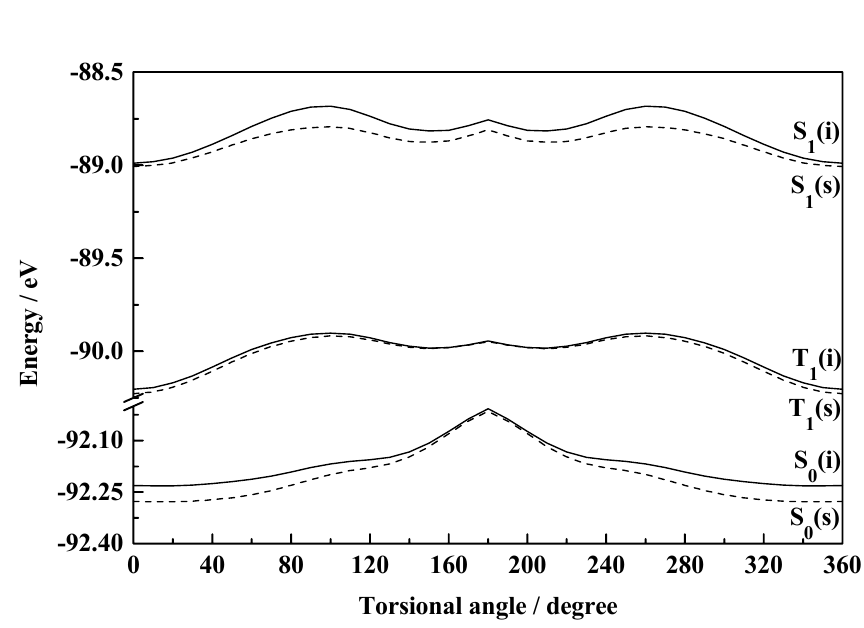
Figure 6. Plot of total molecular energy as a function of torsional angle (2-1-7-8) in S states of HPT (i, isolated; s, solvated in